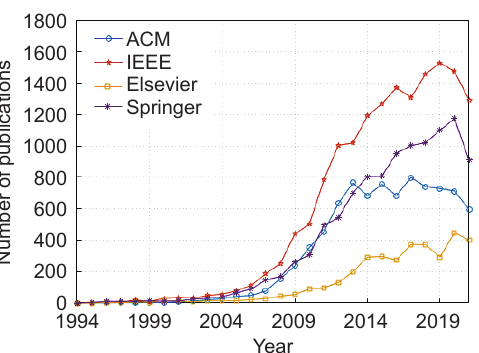
Fig. 2 Overall number of publications.